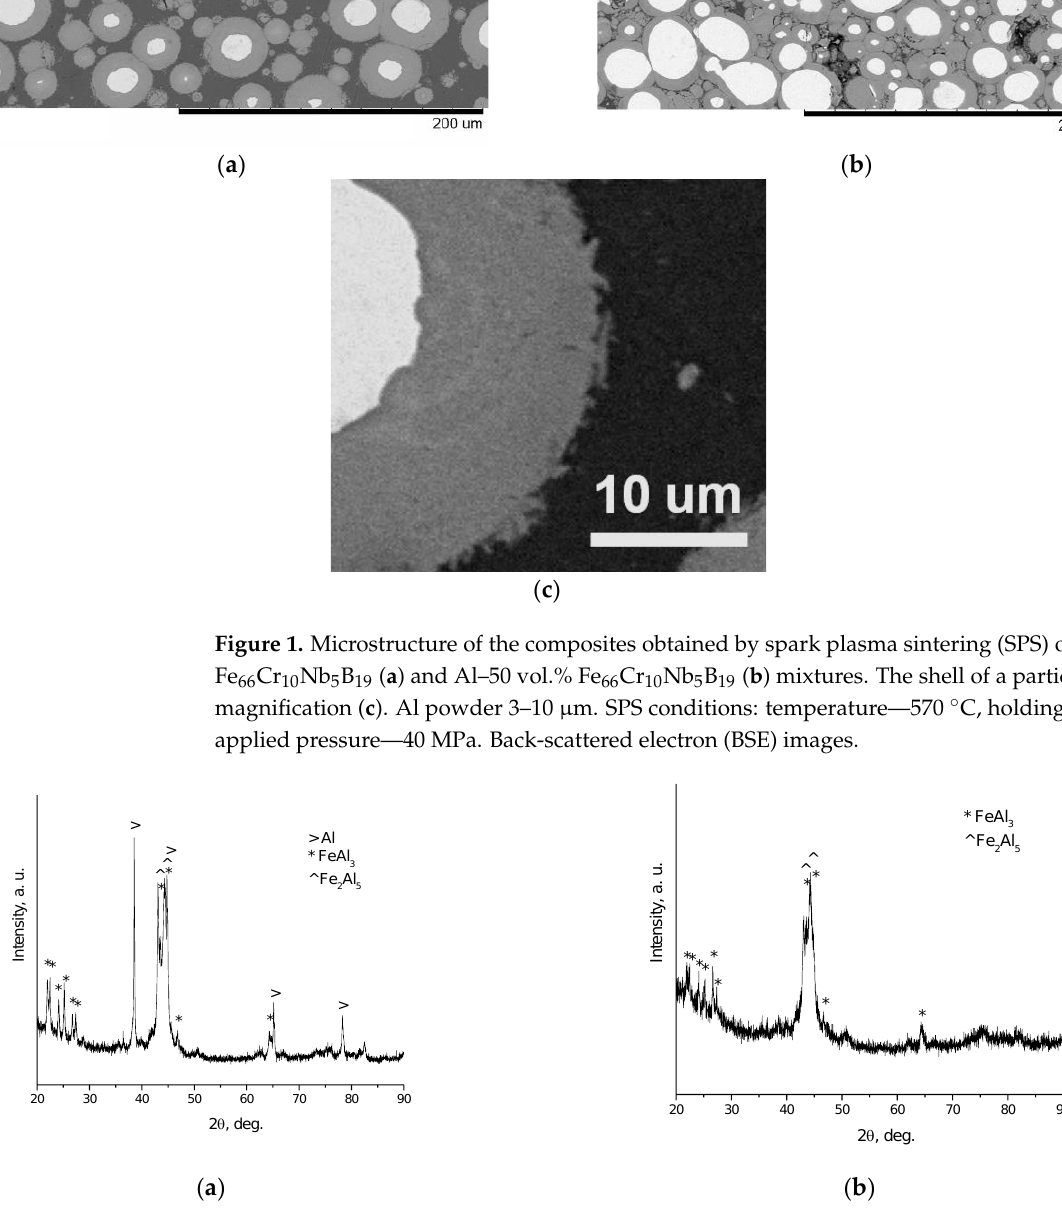
Figure 2. XRD patterns of the composites obtained by SPS of Al – 20 vol.% Fe 66 Cr 10 Nb 5 B 19 ( a ) and Al – 50 vol.% Fe 66 Cr 10 Nb 5 B 19 ( b ) mixtures. SPS conditions: temperature — 570 °C, holding time — 3 min, applied pressure — 40 MPa.